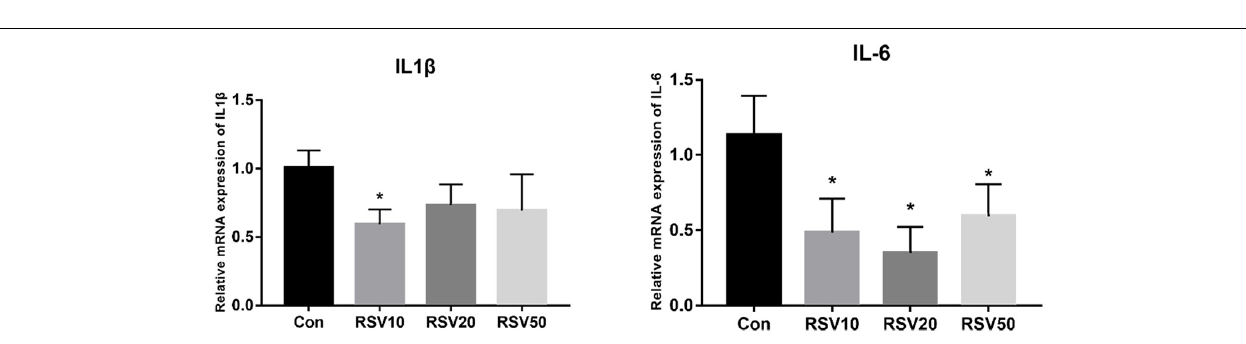
FIGURE 4 | Effect of RSV on the expression of IL-1 β and IL-6 in weaned mice. The relative mRNA expression of IL1 β and IL-6 was detected by qRT-PCR. Con = control group, RSV10 = 10 mg/kg RSV, RSV20 = 20 mg/kg RSV, RSV50 = 50 mg/kg RSV. *Means with single asterisks are significantly different ( p < 0.05) from values of control group, and all the data are expressed as the means ±